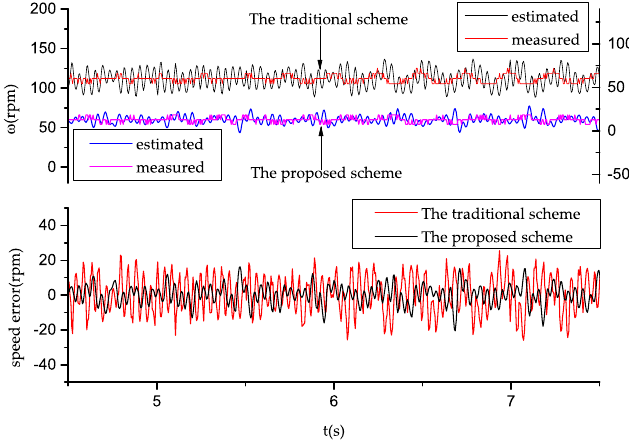
Figure 19. The steady performance comparison of two sensorless control